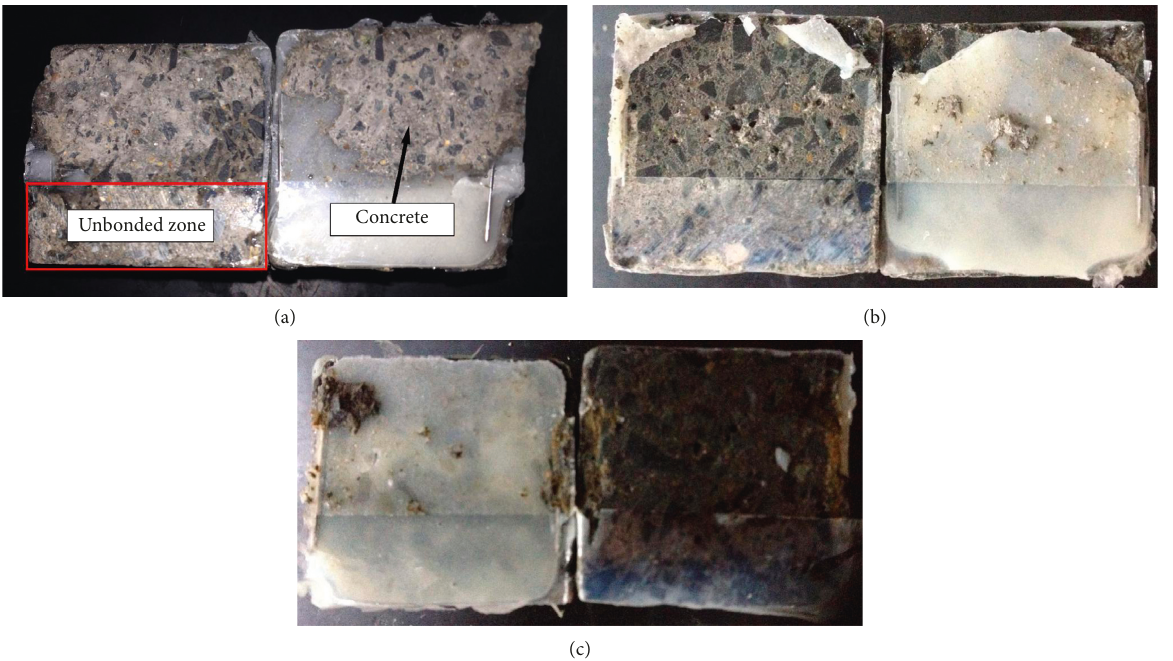
Figure 7: Failure modes of the sandwiched four-point bending specimen: (a) control, (b) after 2 weeks of water immersion, and (c) after 4 weeks of water immersion.